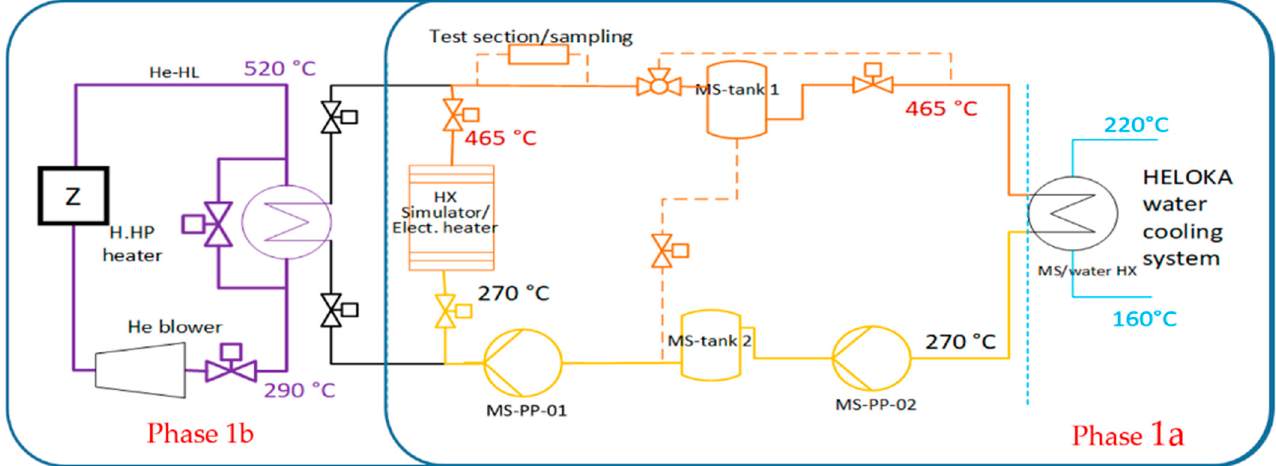
Figure 3. Schematic diagram of HELOKA-US as in Phase 1a and Phase 1b. MS: molten salt; PP: Pump; HX: heat exchanger.